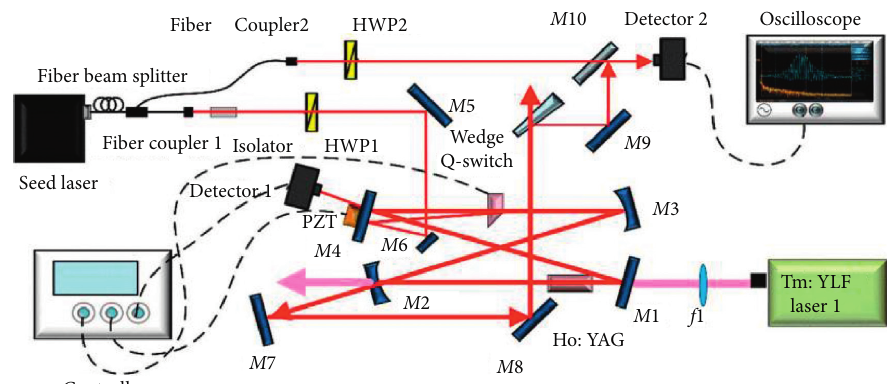
Figure 14: Ho:YAG single-frequency laser with seed injection [56].